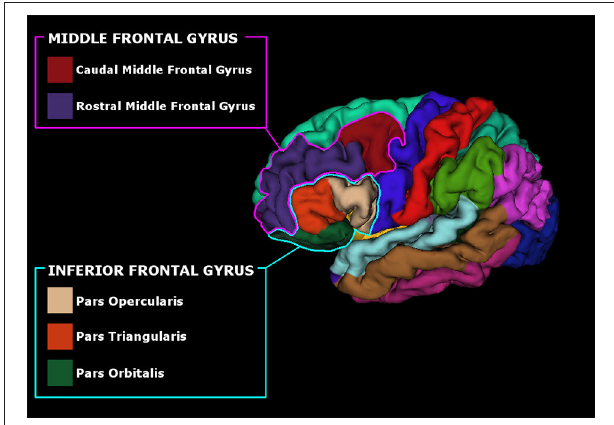
FIGURE 1 | Pial surface reconstruction representing the parcellated subregions of the Inferior Frontal Gyrus (IFG) and Middle Frontal Gyrus (MFG).